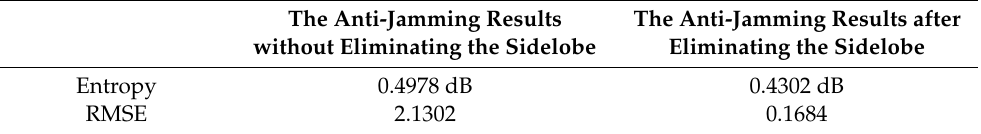
Table 5. Imaging entropies and RMSE values of two different algorithms.